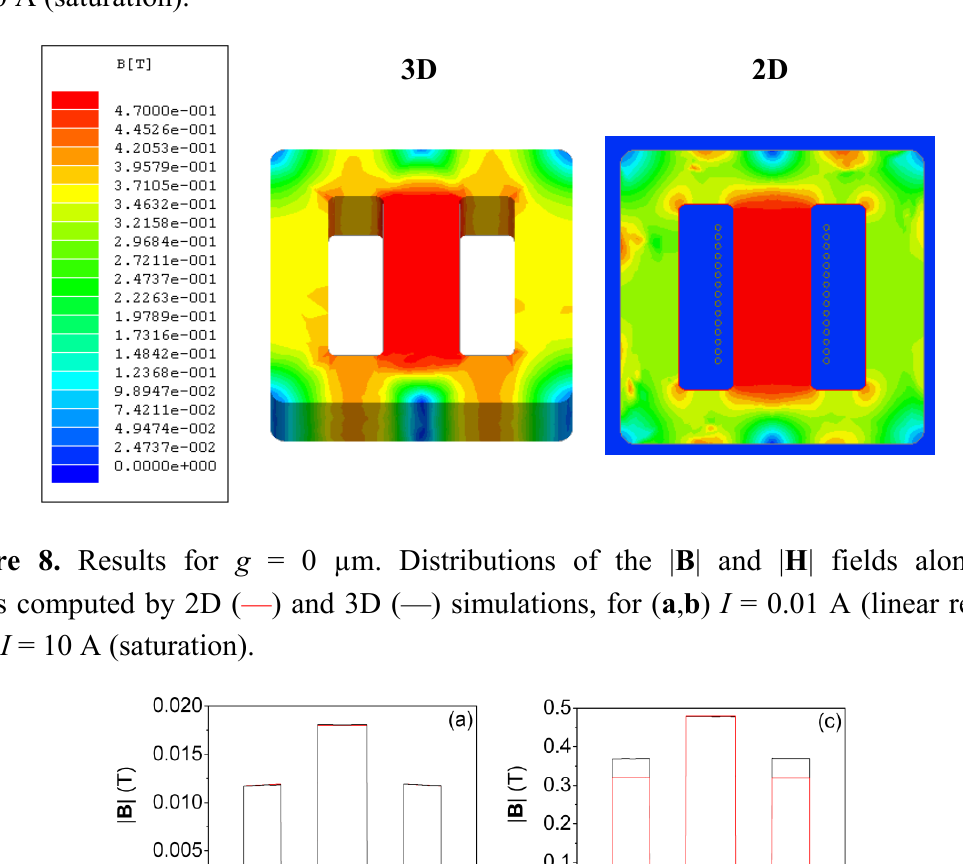
I = 10 A (saturation).